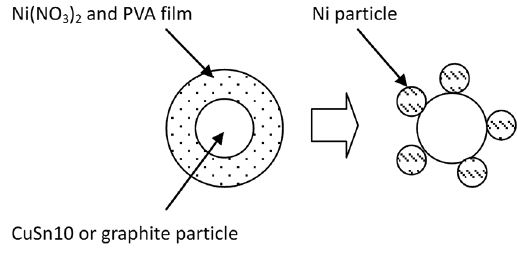
Figure 3: Schematic diagram of formation of Ni particles attached on the surface of CuSn10 particle or graphite particle. graphite and Ni addition. Its friction coefficient increases to maximum value of 0.38 after being worn for 260 s, and then decreases to 0.23 gradually. Its friction coefficient amplitude is greater than that of composites with 8 vol%, 10 vol%, 12 vol% graphite and Ni addition, which indicates its unstable friction processes because its graphite content is very low and integrated lubricant film cannot be formed between wear pairs during the friction processes 16 . The friction processes of the composites with graphite content of 8 vol%, 10 vol% and 12 vol% are stable and their average friction coefficient is 0.19, 0.12 and 0.17 during friction processes,